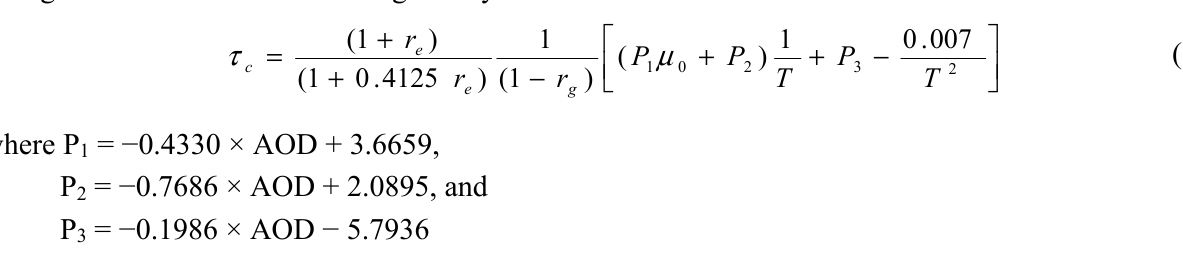
Figure 5. Convergence of iterative retrieval algorithm for ( a ) COD and ( b ) R